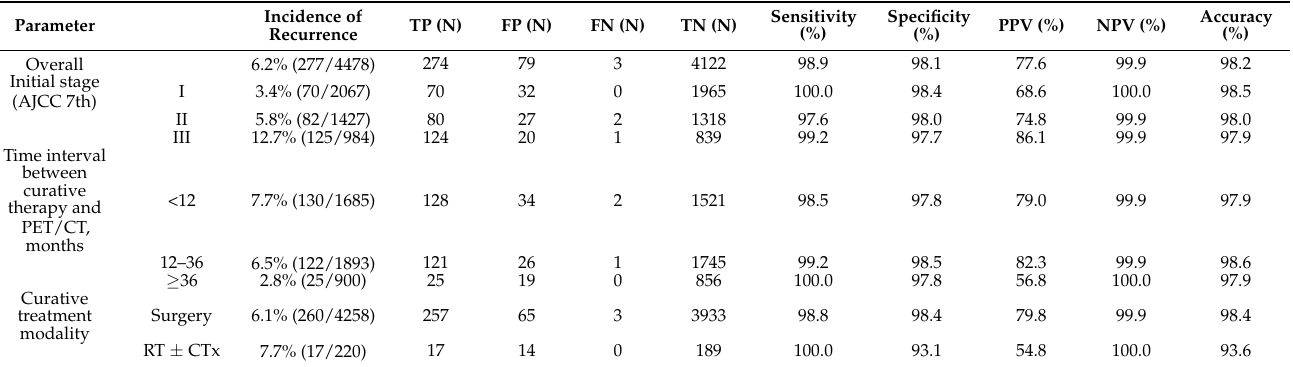
Table 2. Diagnostic performance of surveillance FDG PET/CT scans for detection of recurrent